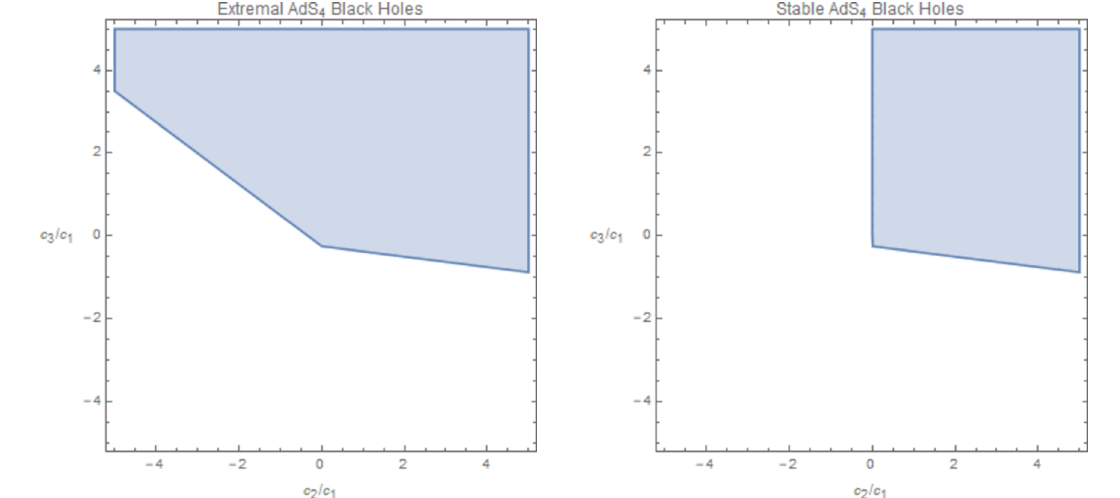
Figure 2 . Blue regions are allowed after imposing that the entropy shift is positive. (Left): allowed region after imposing that extremal black holes have positive entropy shift (Right): allowed region after imposing that all stable black holes have positive entropy